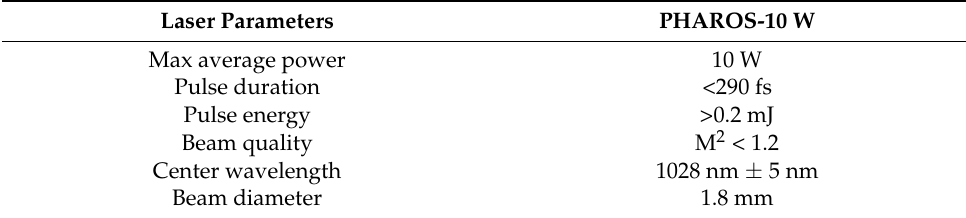
Figure 2. ( a ) Circular laser drilling trajectories and ( b ) spiral laser drilling trajectories.